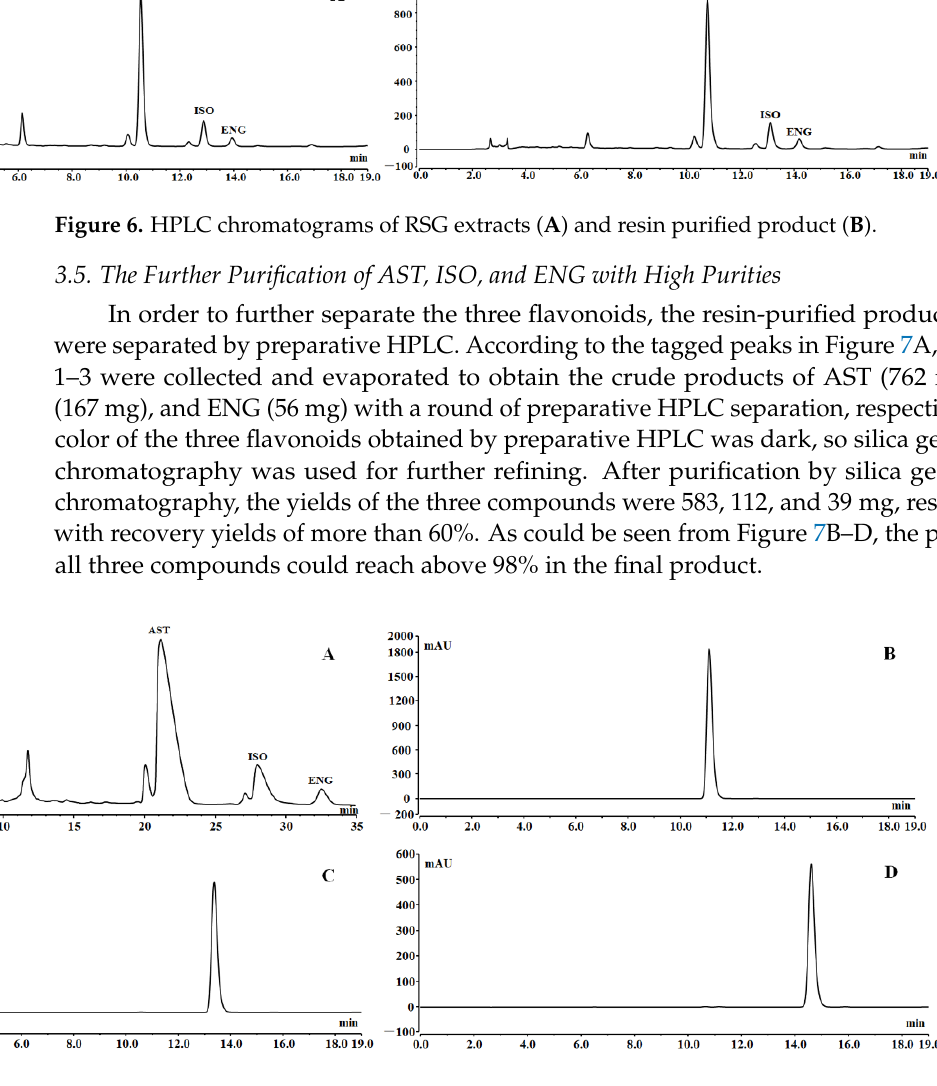
Figure 7. Preparative HPLC chromatogram ( A ); chromatograms of the final prepared AST ( B ), ISO ( C ), and ENG ( D ).